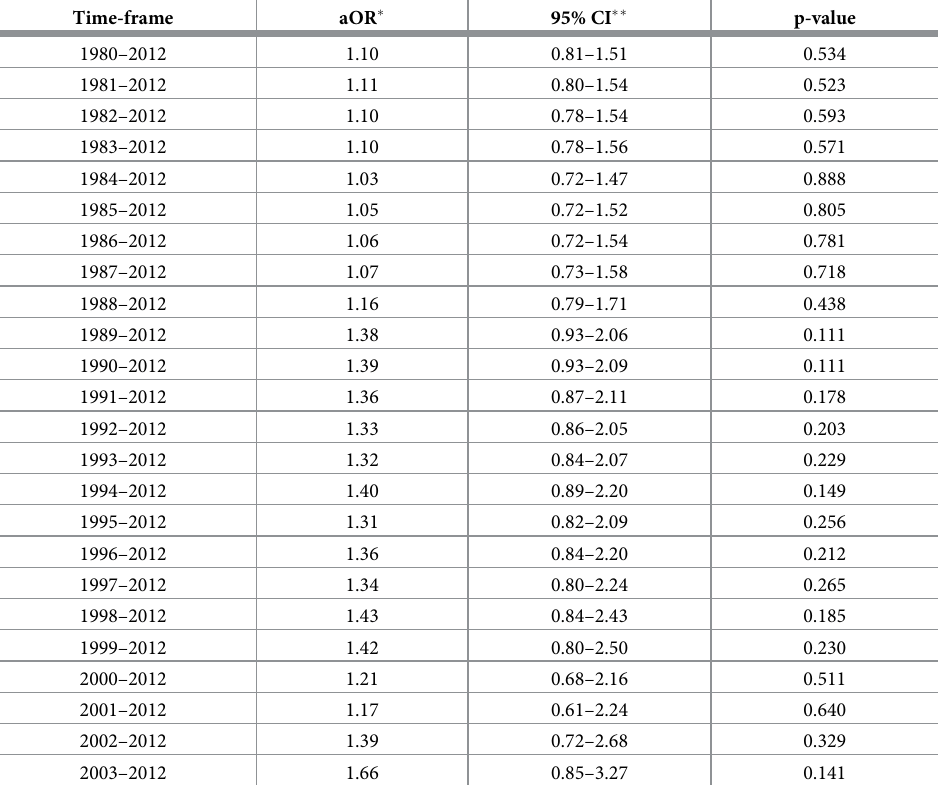
Table 4. The odds ratios of low household income among tuberculosis and non-tuberculosis group by periods within high childhood socioeconomic position strata. Time-frame aOR � 95% CI